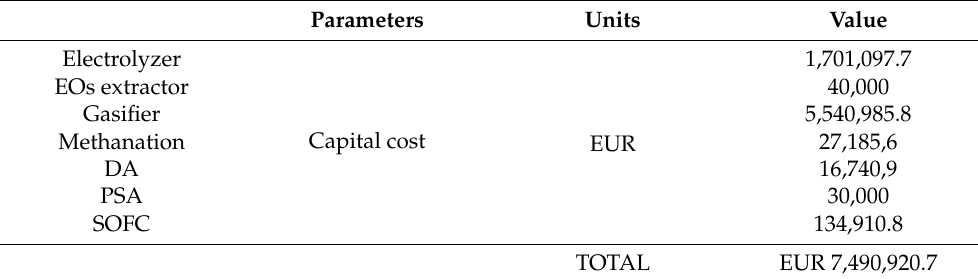
Table 9. Initial investment for the proposed multi-product biorefinery.